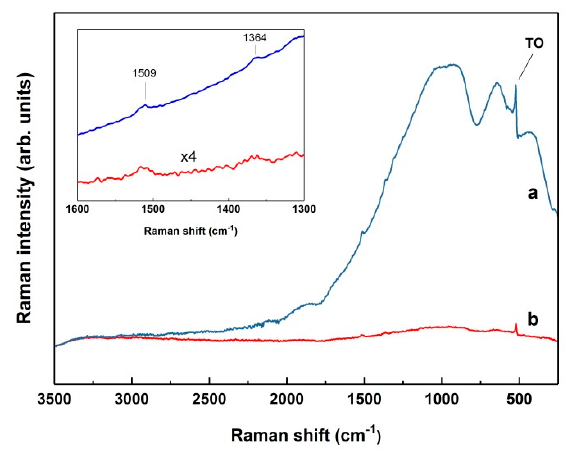
Figure 6. Comparison of FT-Raman spectra of the highest detectable R6G concentration of (10 − 2 M) on non-metallized samples: ( a ) pSi S1, ( b ) RF S2 (both 100 scans, 500 mW). Wavenumber range of 1600–1300 cm − 1 is magnified in inset. Two weak peaks at 1509 and 1364 cm − 1 corresponding to the most prominent bands of R6G are visible.